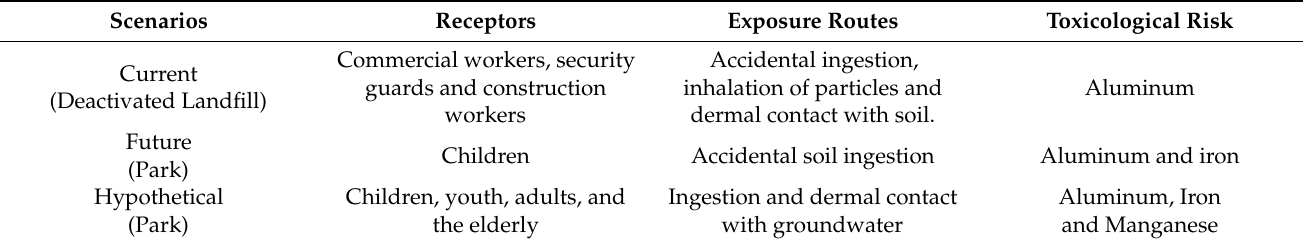
Table 1. Results of Human Health Risk Assessment